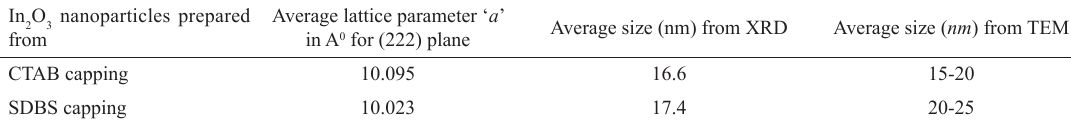
O samples capped with CTAB and SDBS from XRD, TEM 2 3